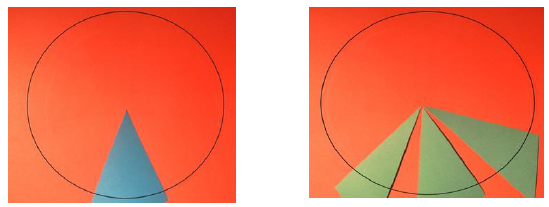
Figure 4: Various abundances were measured using different number of colourful celloluse sections on the background. The FOV region was drawn by using graphical instruments.